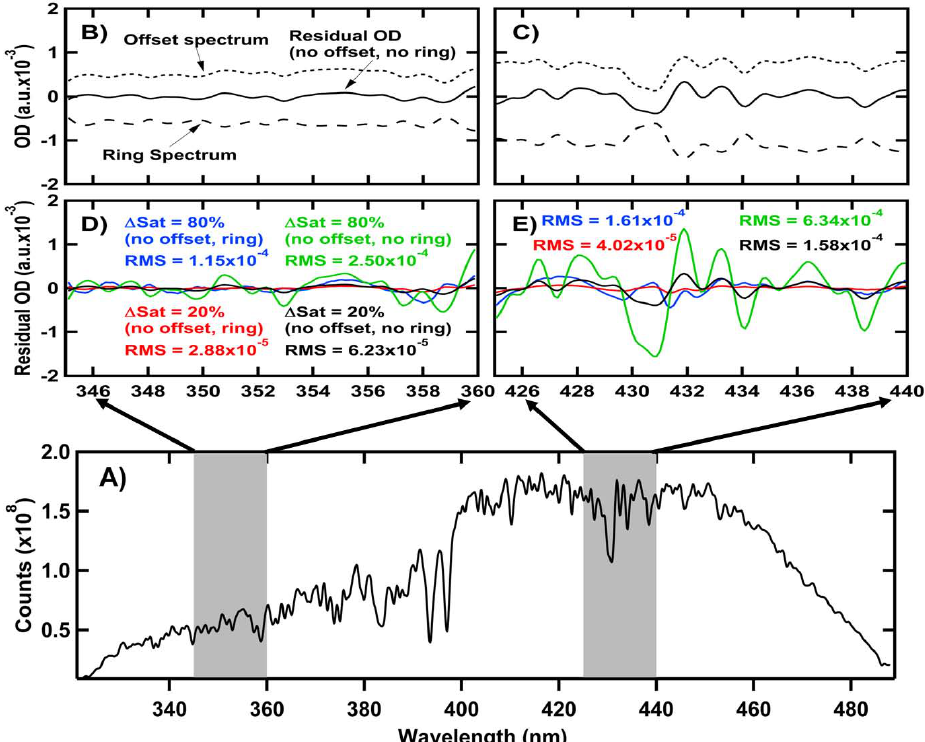
Fig. 3. Assessment of detector non-linearity through simulated spectra. Bottom panel ( A ) depicts an example spectrum with the wavelength intervals analyzed highlighted with the grey background. Top panel ( B and C ) demonstrates the spectral cross-correlation between the residual structure due to nonlinearity (solid line, no Ring fit and no offset), the Ring fit (dashed line), and the linear intensity offset (dotted line). Middle panel ( D and E ) shows the residual of the analyses for the two wavelength intervals for four different simulated scenarios. In ( D ) and ( E ), the blue and green lines represent data with a saturation level difference (sample – reference) of 80% and the blue line depicts the results including a Ring spectrum in the fitting window and the green line is the results without including the Ring spectrum. The red and black lines represent the corresponding spectra with a saturation level difference of 20%, where the red line is the fit including the Ring spectrum and the black line does not include the